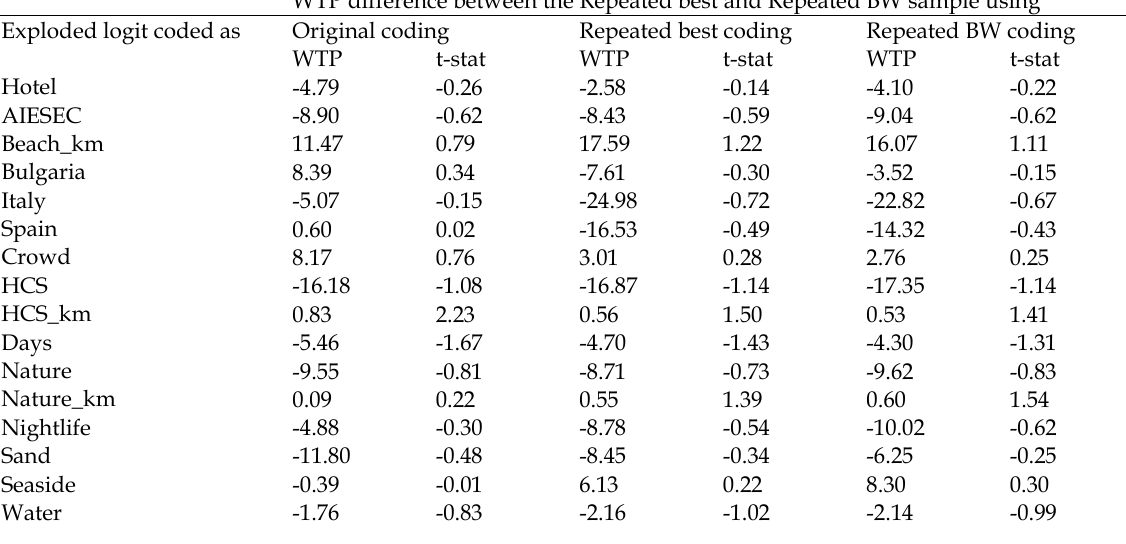
Table 8. Differences in WTP estimates depending on the assumed exploded logit model WTP difference between the Repeated best and Repeated BW sample